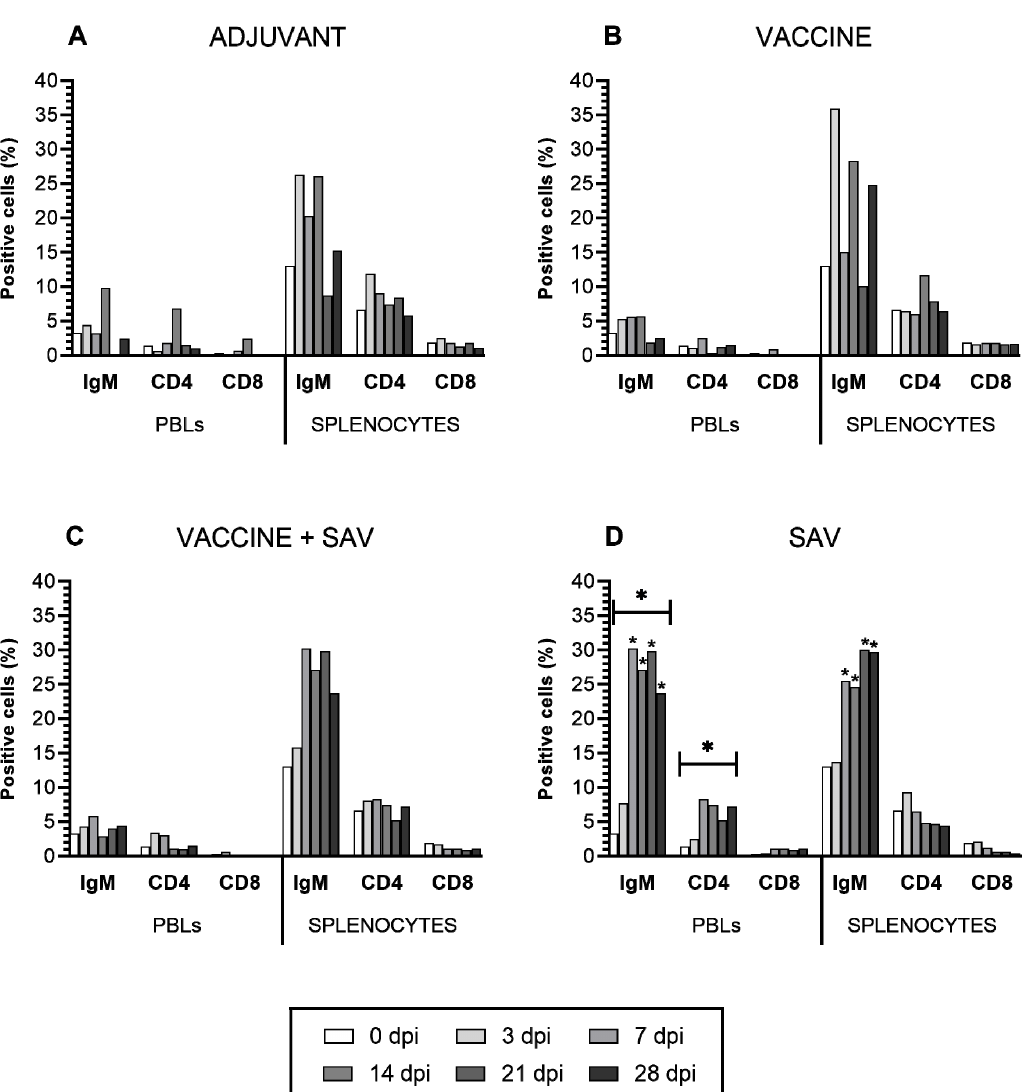
Figure 3. Percentages of IgM, CD4 and CD8 positive cells in PBLs and splenocytes in fish ( n = 4, pooled) at 0, 3, 7, 14, 21, and 28 days post injection with ( A ) adjuvant, ( B ) vaccine, ( C ) SAV challenge following vaccination, and ( D ) SAV challenge. Codes: ‘*’= p ≤ 0.05; black star (*) with bar = comparing percentage of positive cells within a tissue to tissues of other treatment groups; black star (*) = time points compared to 0 dpi within a tissue of each treatment group.